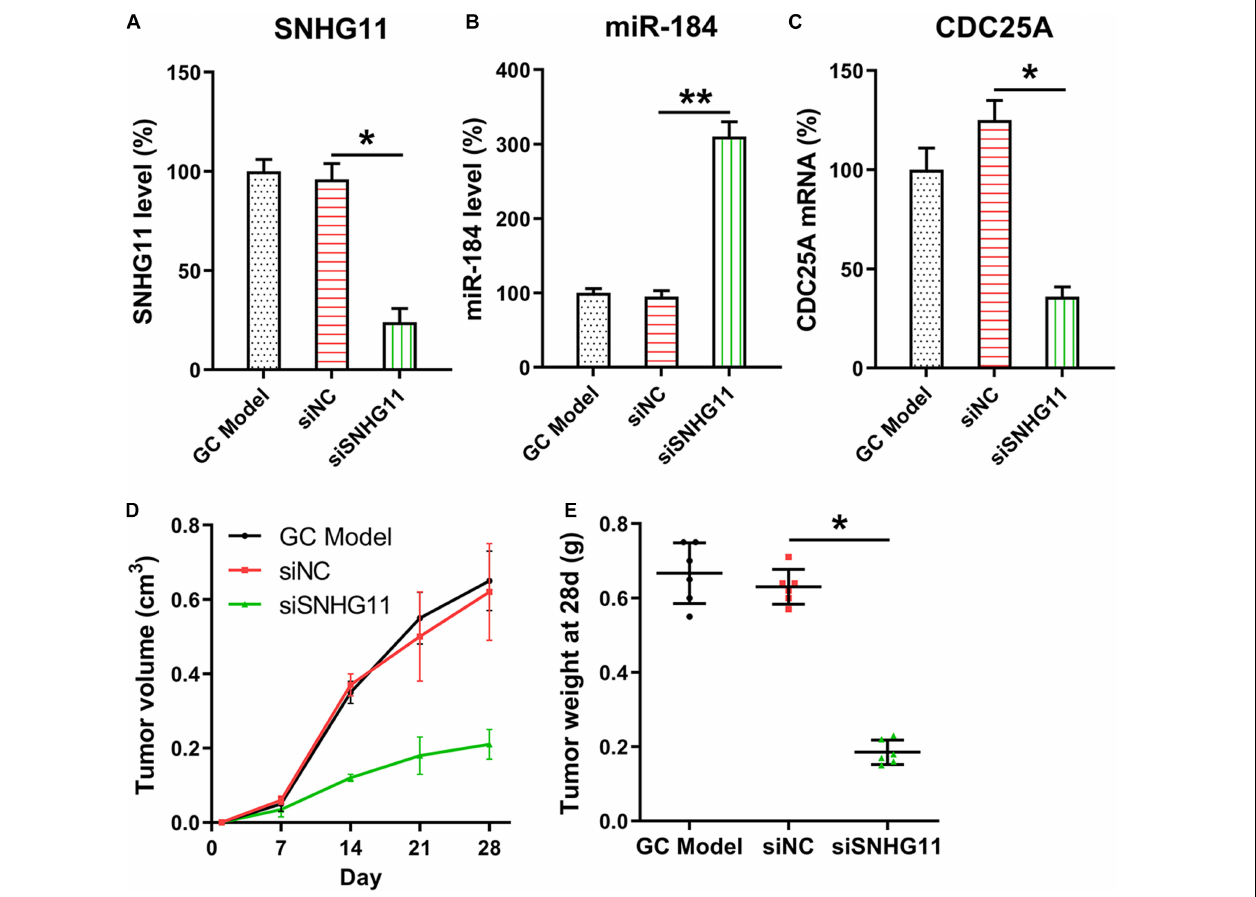
FIGURE 7 | SNHG11 silencing inhibits xenograft GC tumorigenesis. The SGC-7901, SGC-7901-siNC and SGC-7901-siSNHG11 cells were injected through the right back flank of 6 week-old BALB/c-nu mice ( n = 6). (A) SNHG11, (B) miR-184, and (C) CDC25A mRNA expressions in tumor specimens were determined through qPCR. (D,E) Mice were sacrificed, and the tumors were weighed 4 weeks after inoculation. Tumor weight and volume were measured. These data are shown as average ± SD . * P < 0.05, ** P < 0.01 vs. indicated